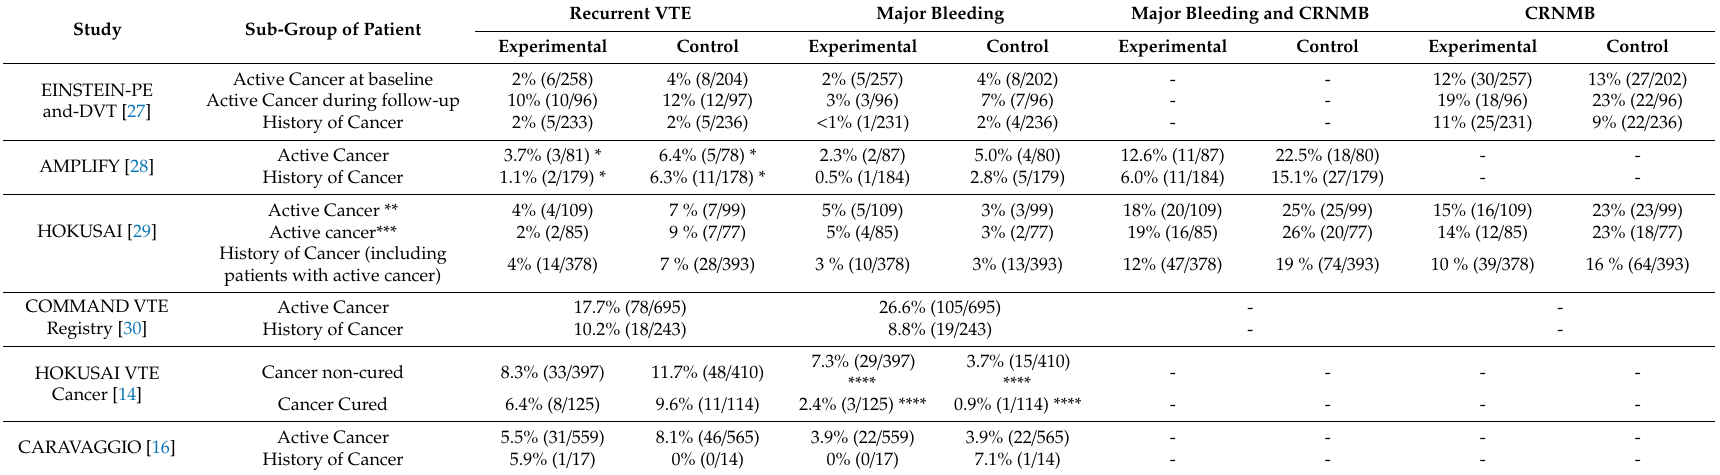
Table 2. Reported rates of recurrent venous thromboembolism (VTE) and bleeding in patients with an active cancer and in those with an history of cancer.